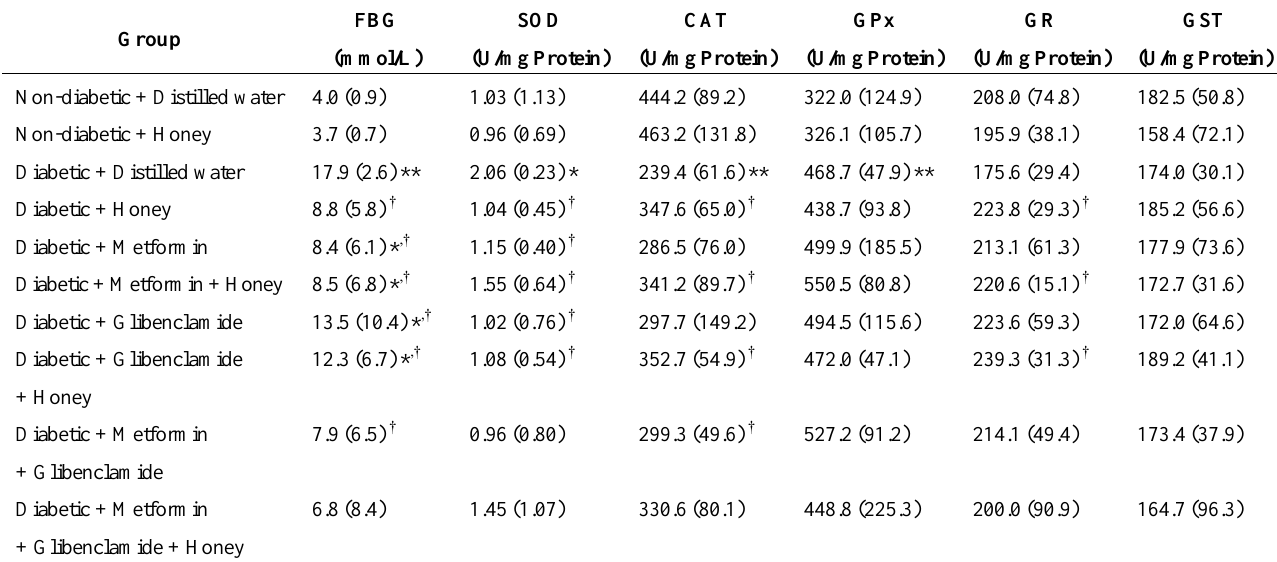
Table 1. Effects of honey, metformin, glibenclamide or their combinations on fasting blood glucose and antioxidant enzymes in the kidneys of control and streptozotocin-induced diabetic